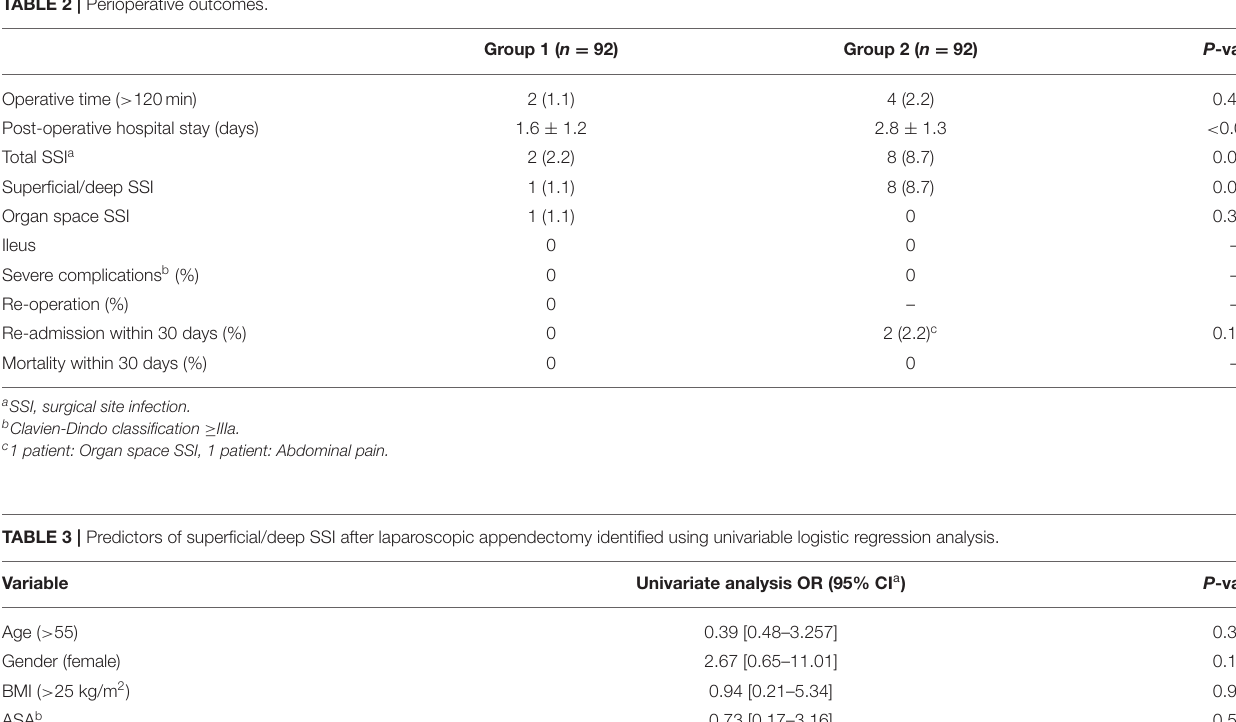
TABLE 2 | Perioperative outcomes.